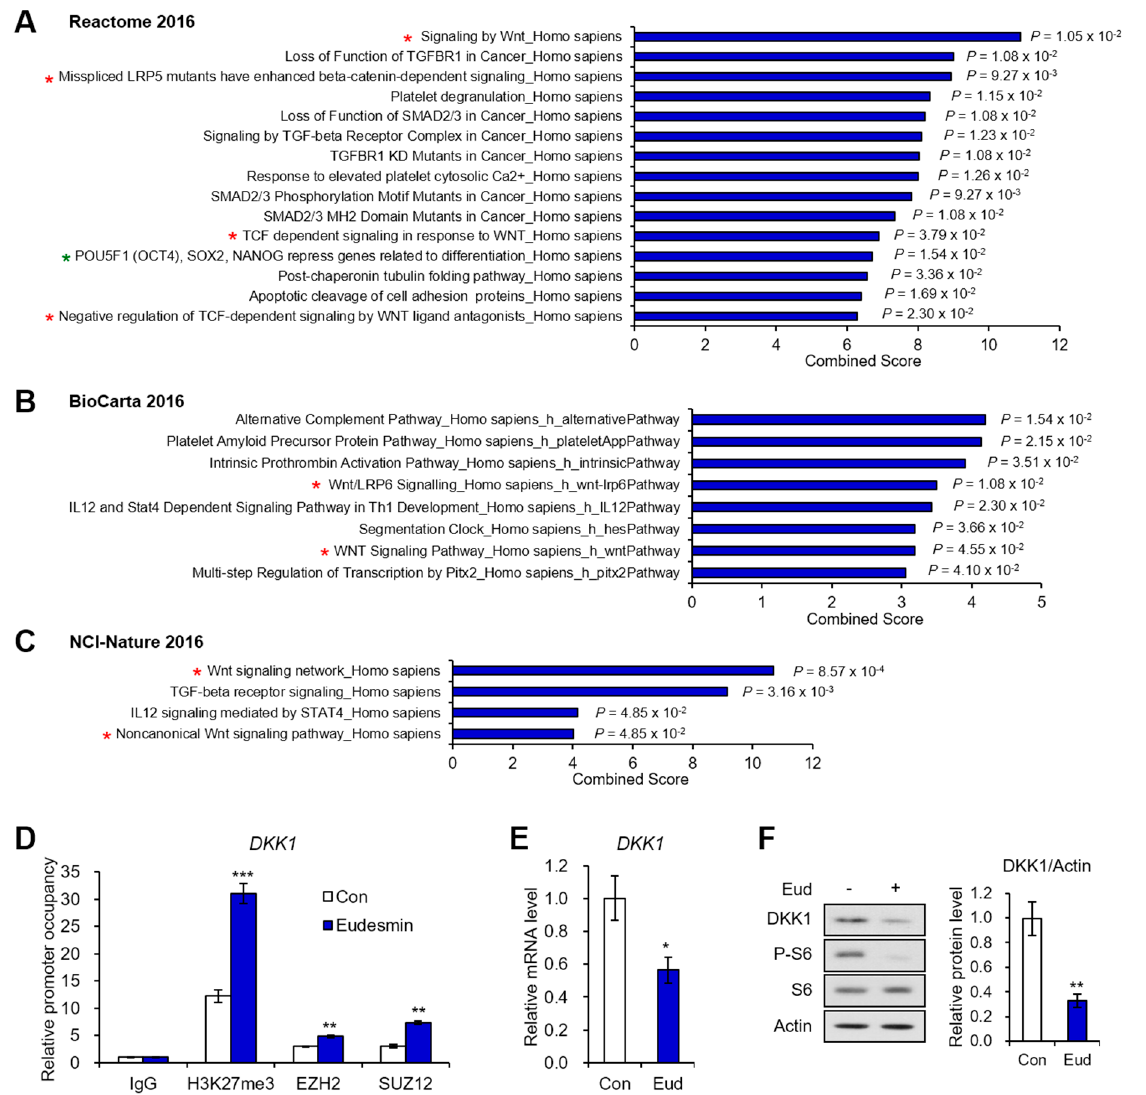
Figure 4. PRC2 target genes downregulated by eudesmin are involved in Wnt signaling. ( A ) Analysis of PRC2 target genes which are downregulated by eudesmin treatment with Reactome 2016 database in Enrichr. ( B ) Analysis of PRC2 target genes which are downregulated by eudesmin treatment with BioCarta 2016 database in Enrichr. ( C ) Analysis of PRC2 target genes which are downregulated by eudesmin treatment with NCI-Nature 2016 database in Enrichr. ( D ) H7 embryonic stem cells were treated with or without eudesmin (80 µ M) for 24 h. ChIP assays were performed with IgG, H3K27me3, EZH2, and SUZ12 antibodies followed by real time PCR with primers for promoter region of DKK1 genes. ( E ) The mRNA levels of DKK1 gene in H7 embryonic stem cells treated with or without eudesmin (80 µ M) for 24 h. ( F ) Immunoblot analysis of H7 embryonic stem cells treated with or without eudesmin (80 µ M) for 24 h. Data represent means ± SEM for n = 3. * p < 0.05, ** p < 0.01, *** p <